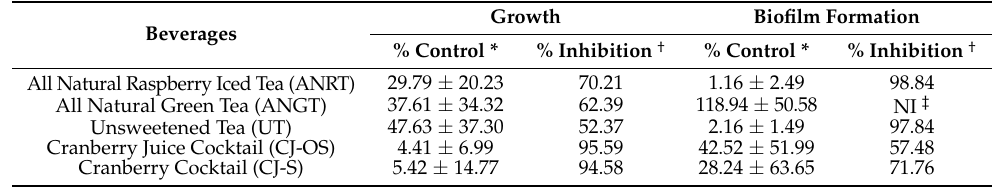
Table 3. The inhibition of ready-to-drink (RTD) bottled beverages at 50% concentration (1:1 dilution) on growth and biofilm formation of children’s supragingival plaque bacteria ( n = 16). Growth Biofilm Formation Beverages % Control * % Inhibition † % Control * % Inhibition † All Natural Raspberry Iced Tea (ANRT) 29.79 ±